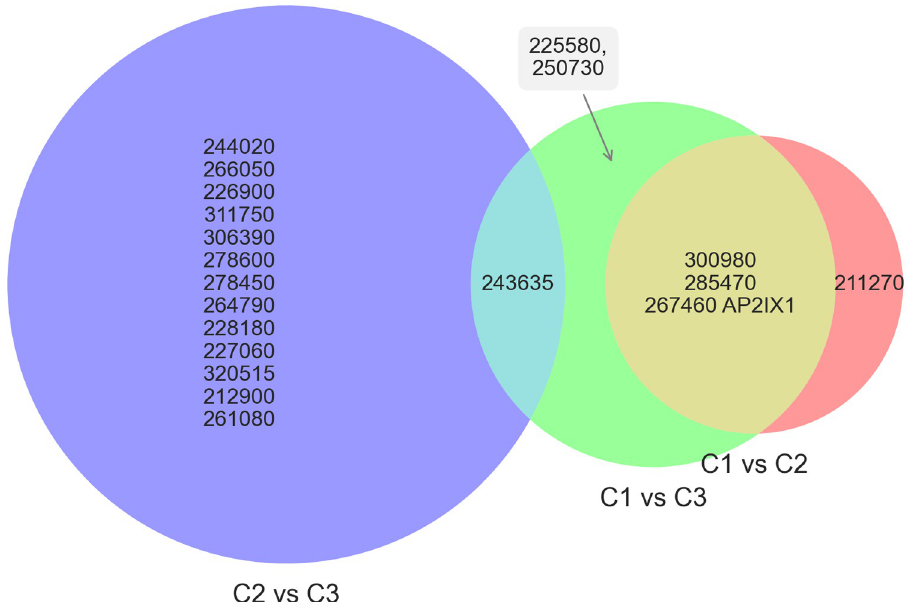
Fig 4. Differentially expressed genes between clonally derived